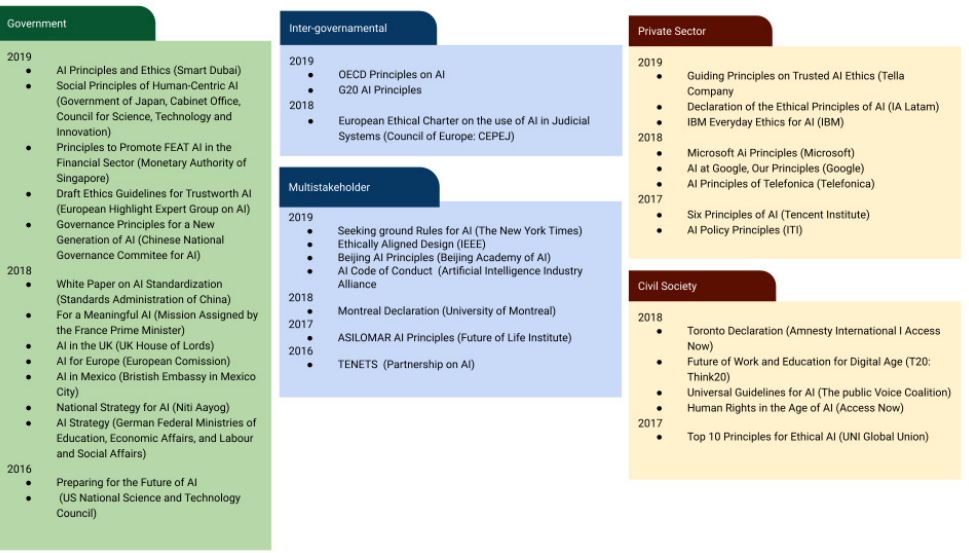
Figure 2. Summary on AI Principles according to Berkman Klein Center